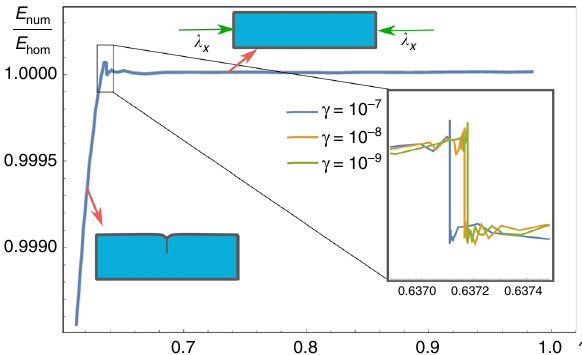
Fig. 4 Numerical results. The solid curves depict the ratio of the total elastic energy E num of the numerical simulation and the corresponding energy E hom of the homogeneously compressed slab at different values of the damping coef fi cient γ . The inset shows that the resulting nucleation limit tends to the critical threshold of λ cr ¼ 0 : 6372 whilst decreasing the damping factor, in excellent agreement with the prediction of Eq.